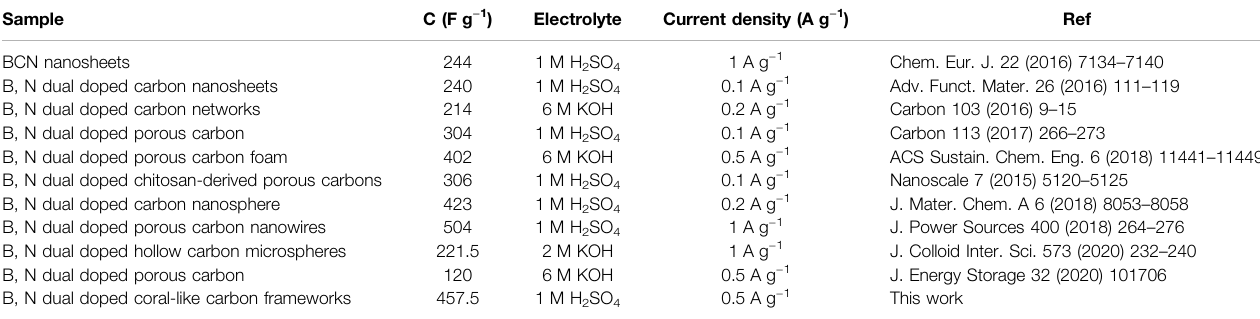
TABLE 3 | Comparison of speci fi c capacitance of BN-CCF with other B, N dual doped carbons reported in the literatures. Sample C (F g − 1